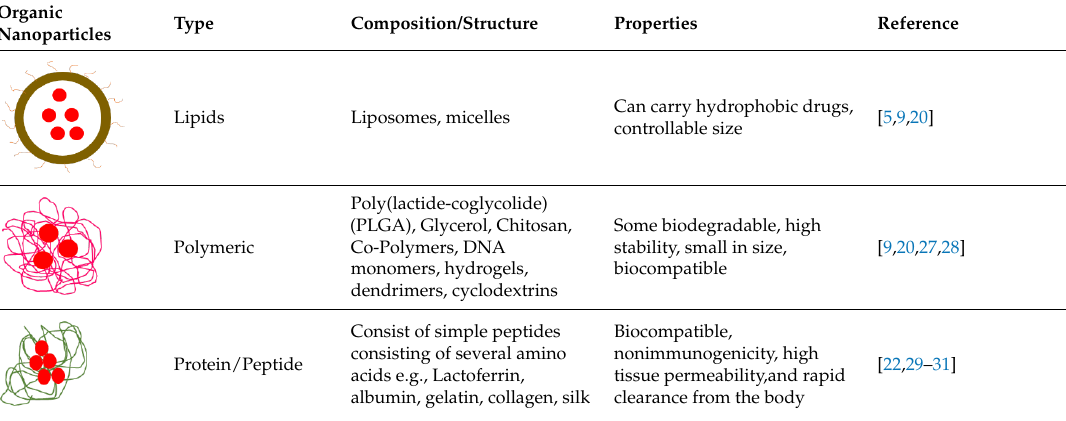
Table 1. Composition-structure and properties of organic and inorganic nanoparticles.